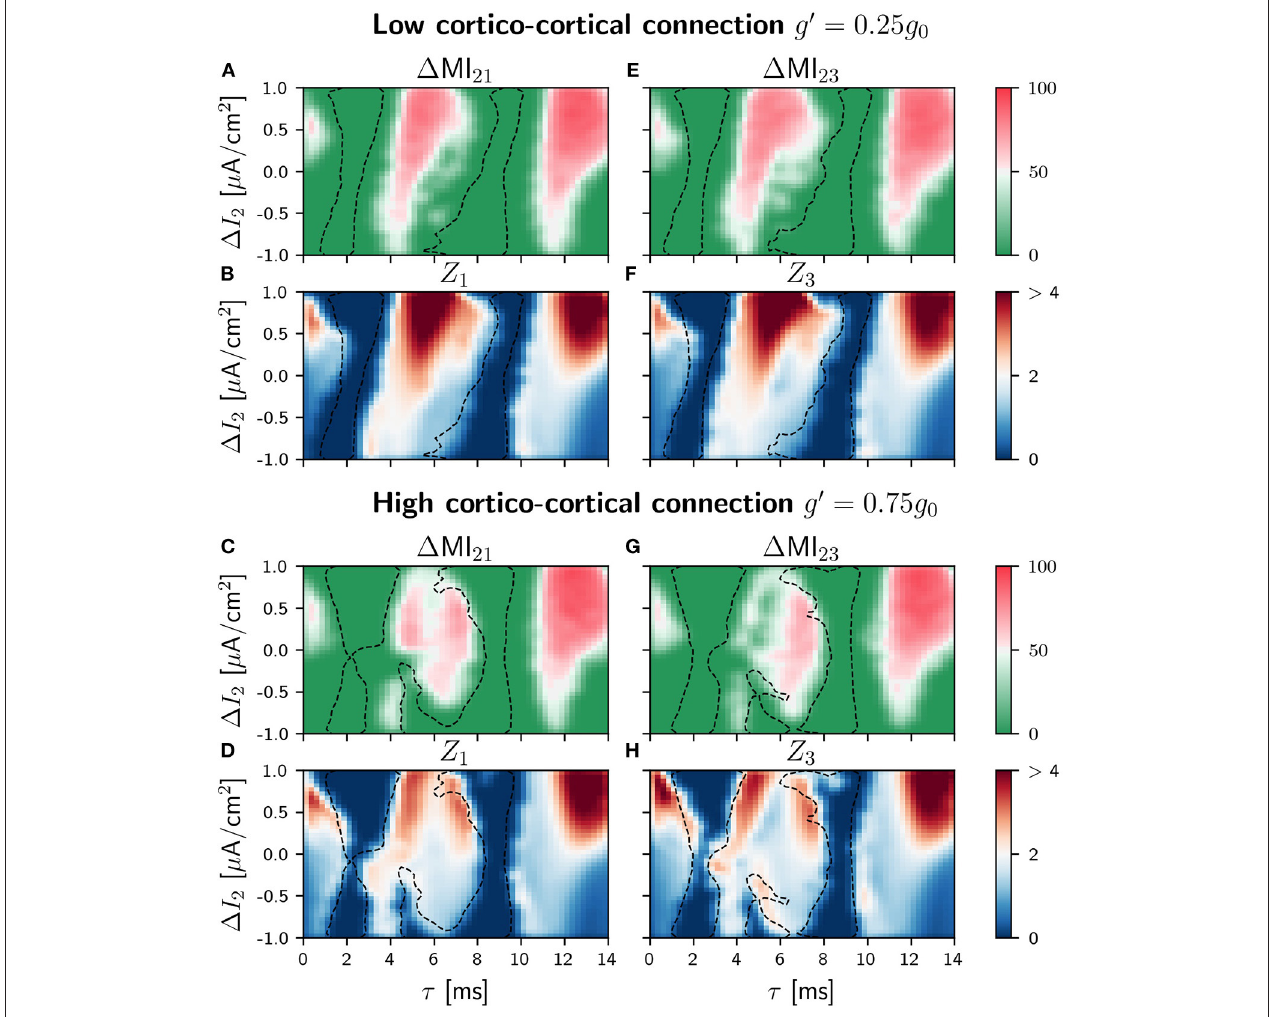
0.25 g 0 (A,E) and g ′ 0.75 g 0 (C,G) when a slow modulation is injected. Integral of the = = 0.25 g 0 (B,F) and g ′ 0.75 g 0 (D,H) when a fast signal is injected. All of them as a function of the delay τ and the frequency = =